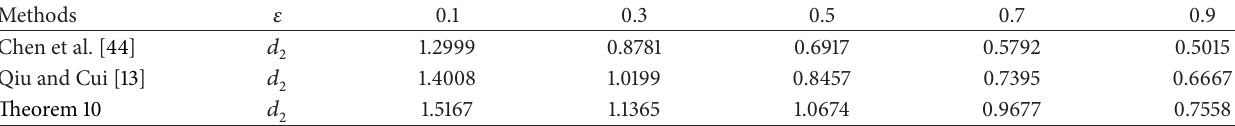
Table 5: Maximum upper bound of 𝑑 2 with different 𝜀 and parameter 𝜇 = 0 .